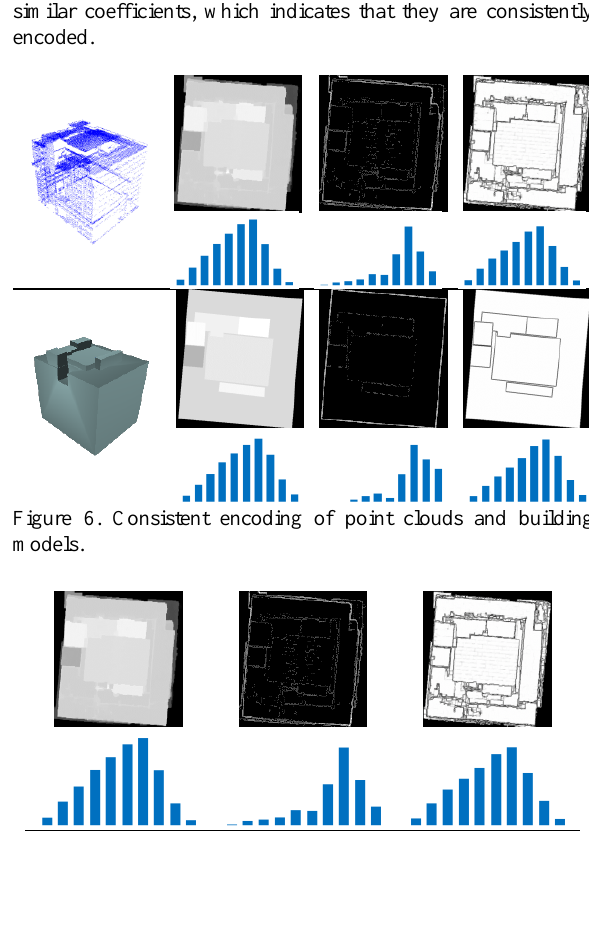
Figure 4. Result of line feature.